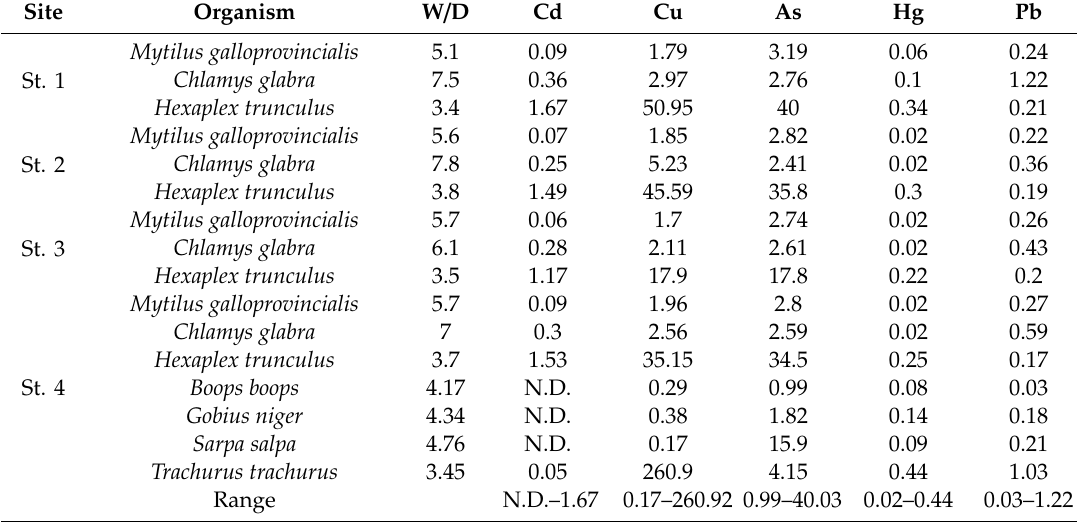
Table 6. Mean values of As, Cd, Cu, Hg and Pb (mg / kg wet weight) and wet / dry ratio in soft tissues of marine organisms ( n = 3; S.D. range =